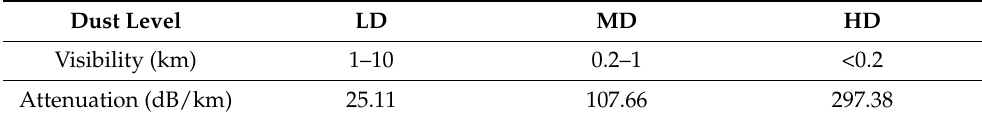
Table 3. Dust storm level with visibility and attenuation [9,24].